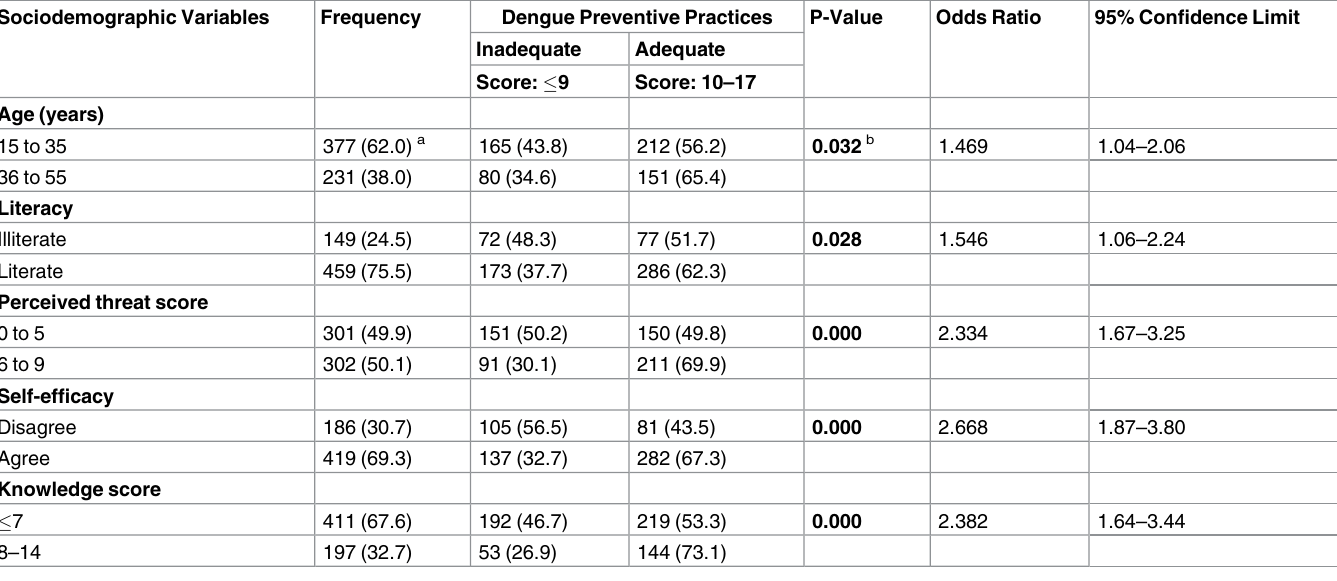
a Values are presented as number (percentage). b Bold font indicates statistical